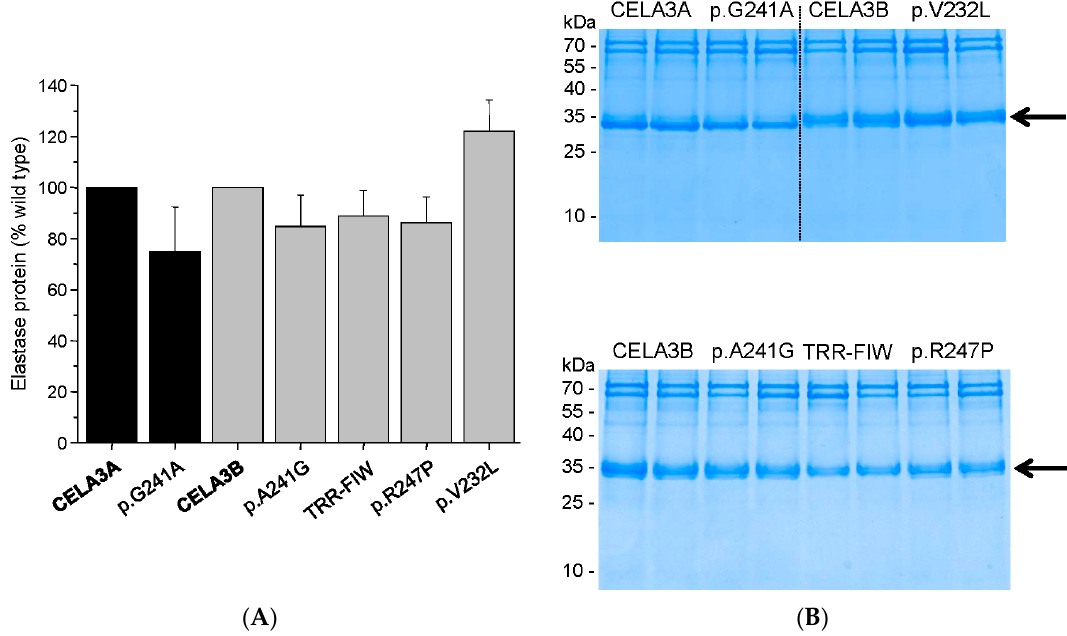
Figure 2. Secretion of CELA3A and CELA3B variants. Human embryonic kidney (HEK) 293T cells were transfected with the indicated constructs and conditioned medium was collected 48 h after transfection. Levels of secreted proelastases were determined by sodium dodecyl sulfate-polyacrylamide gel electrophoresis (SDS-PAGE) and Coomassie Blue staining as described in Materials and Methods. ( A ) Densitometric quantitation of secreted CELA3A and CELA3B. Average values from three transfections with standard deviation (S.D.) are indicated; expressed as percent of wild-type levels; ( B ) Representative gels are shown with samples loaded in duplicate. The molecular mass markers were PageRuler Prestained Protein Ladder (Thermo Scientific, Waltham, MA, USA; PI-26616). The arrow indicates the proelastase bands. The diffuse appearance of the CELA3B bands is likely due to N -glycosylation. TRR-FIW designates the p.T246F, p.R247I, p.R248W variant which is the product of the gene conversion.